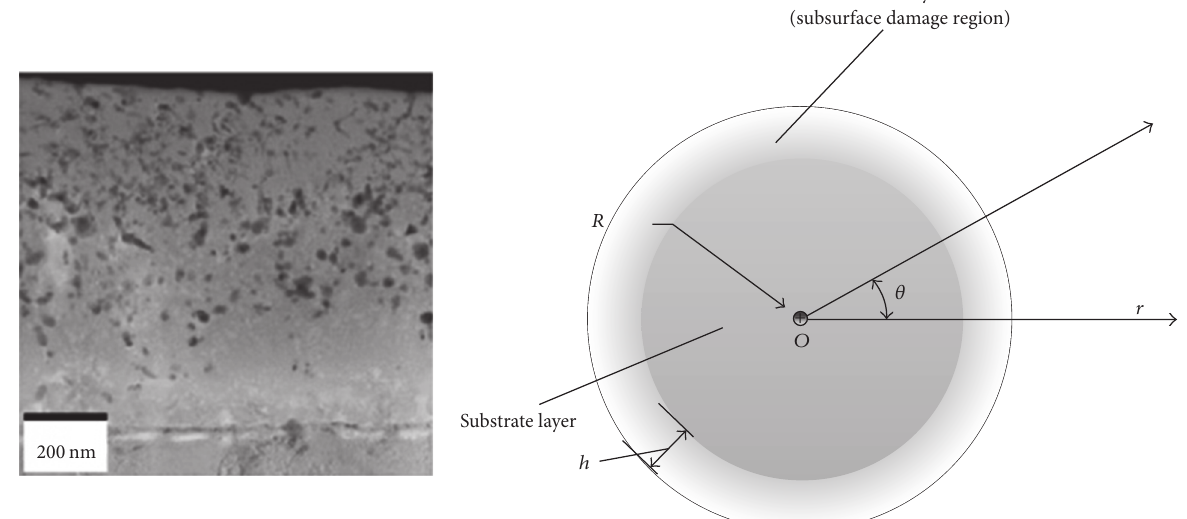
Figure 1: Structure of the cylinder with surface damage (see